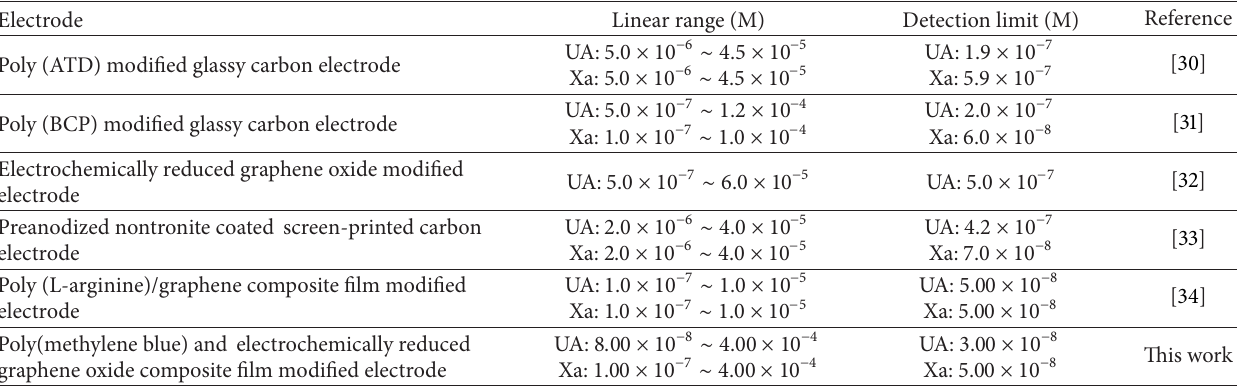
Table 5: Comparison of the proposed method with other electrochemical methods for the simultaneous determination of UA and Xa.